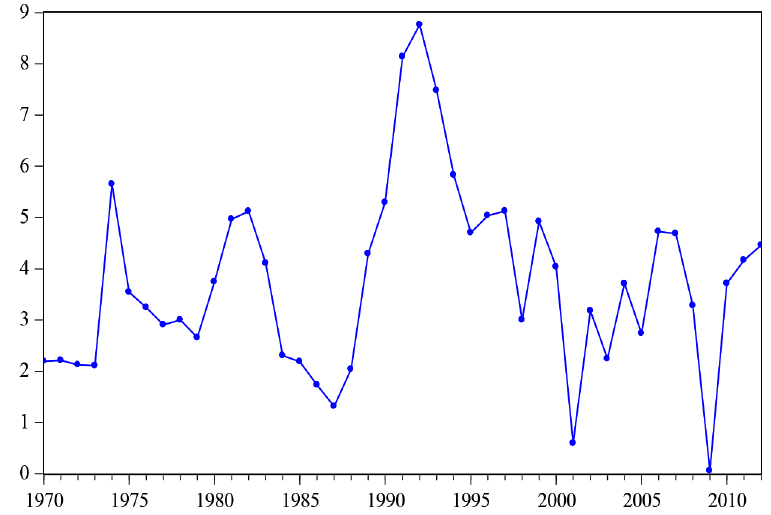
Figure 1. Financial development